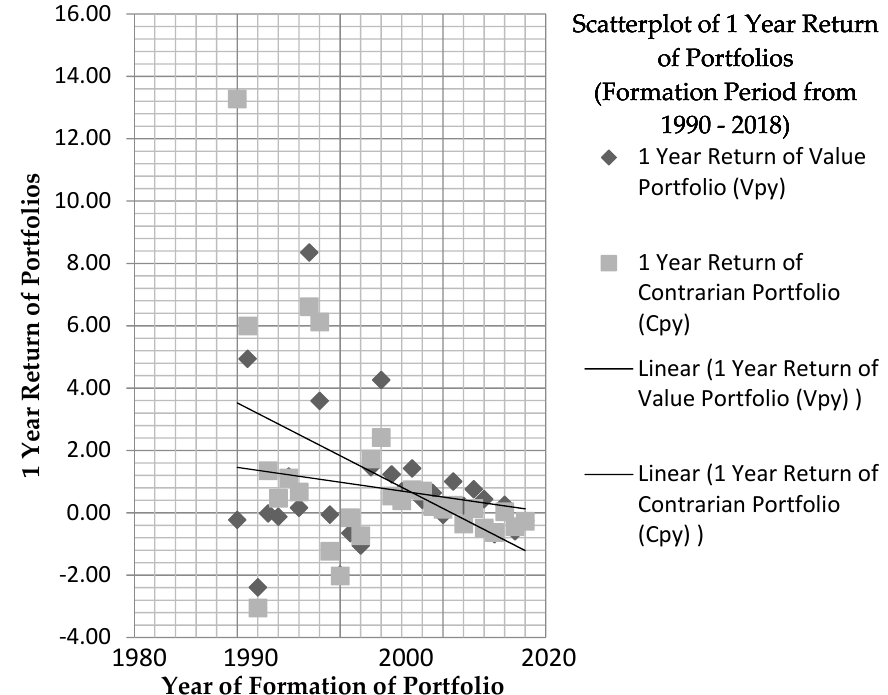
Table 6. Independent samples test for contrarian and value portfolio returns for year t + 2.